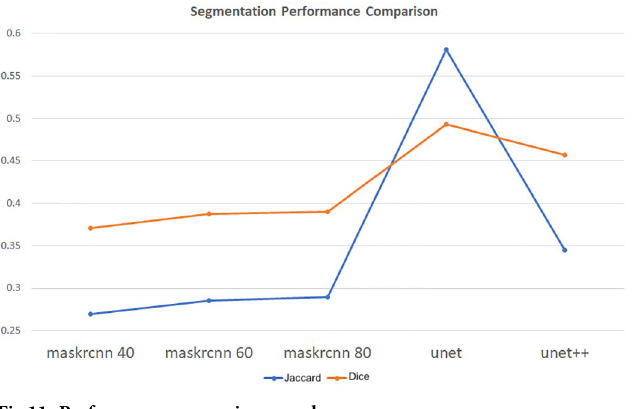
Fig 11. Performance comparison